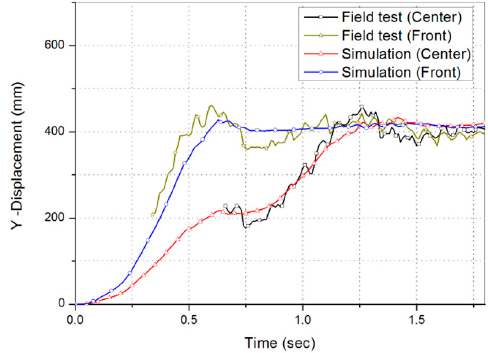
Figure 24. The comparison of Y displacement (lateral) between the field test and the simulation.